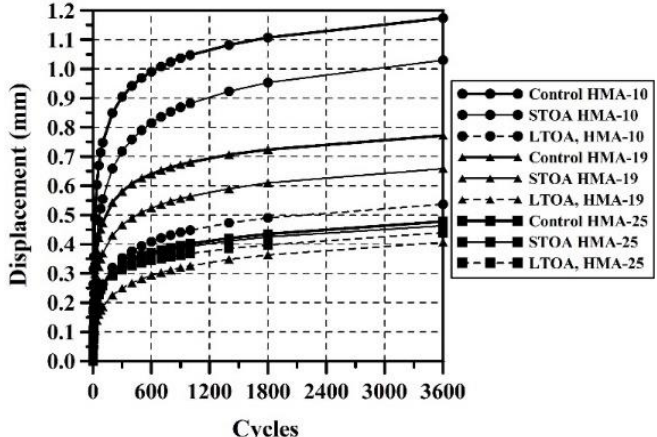
Figure 7. Displacement vs. number of load cycles.